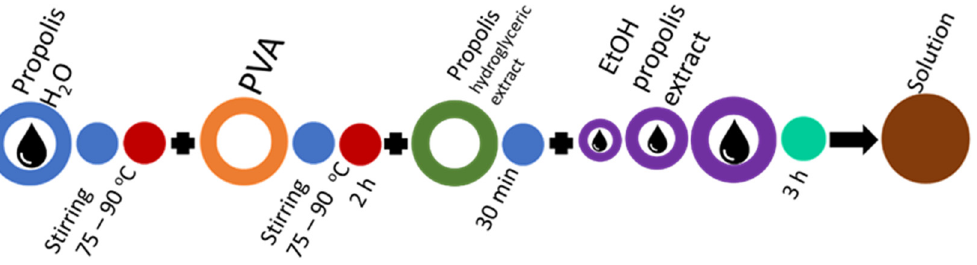
Figure 9. Solution mixing sequence for propolis water and propolis ethyl alcohol extract integration.